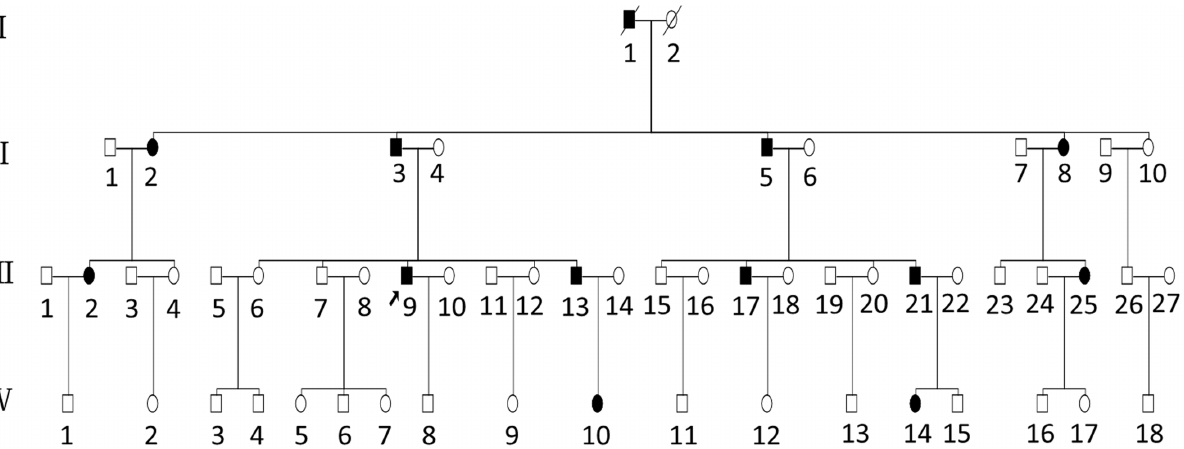
Fig 1. Partial pedigree of the Chinese family with nonsyndromic autosomal dominant SNHL. Open symbols denote unaffected individuals; filled black symbols denote affected individuals. The arrow labels the proband.